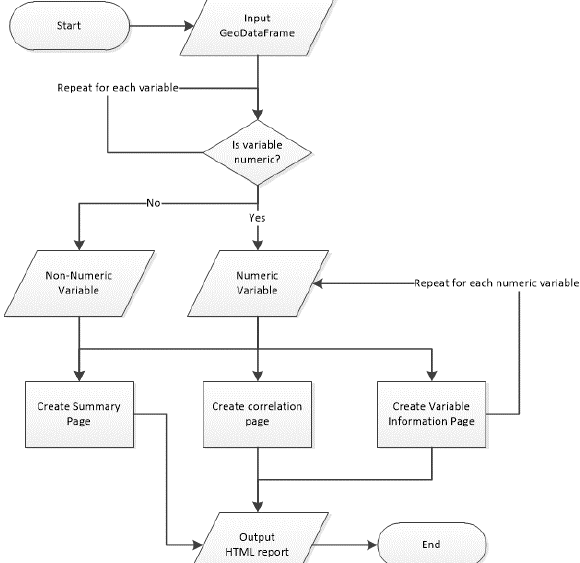
Figure 1. Workflow of the autoESDA